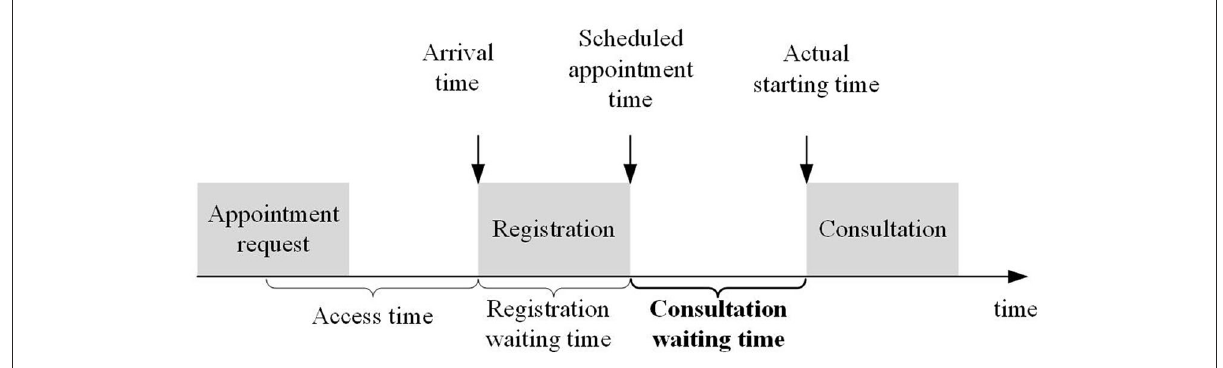
FIGURE1 The general patient flow for getting medical